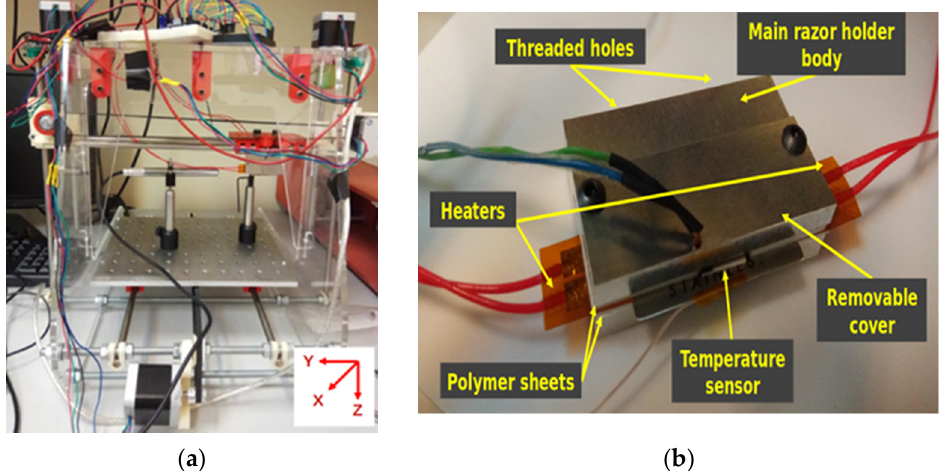
Figure 1. ( a ) Picture of the mPOF cleaving machine; ( b ) detailed view of the razor blade holder and its parts.